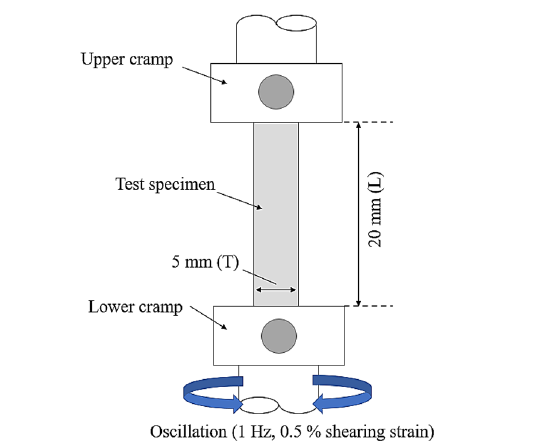
Fig. 4 Experimental set-up for the dynamic mechanical analysis using a